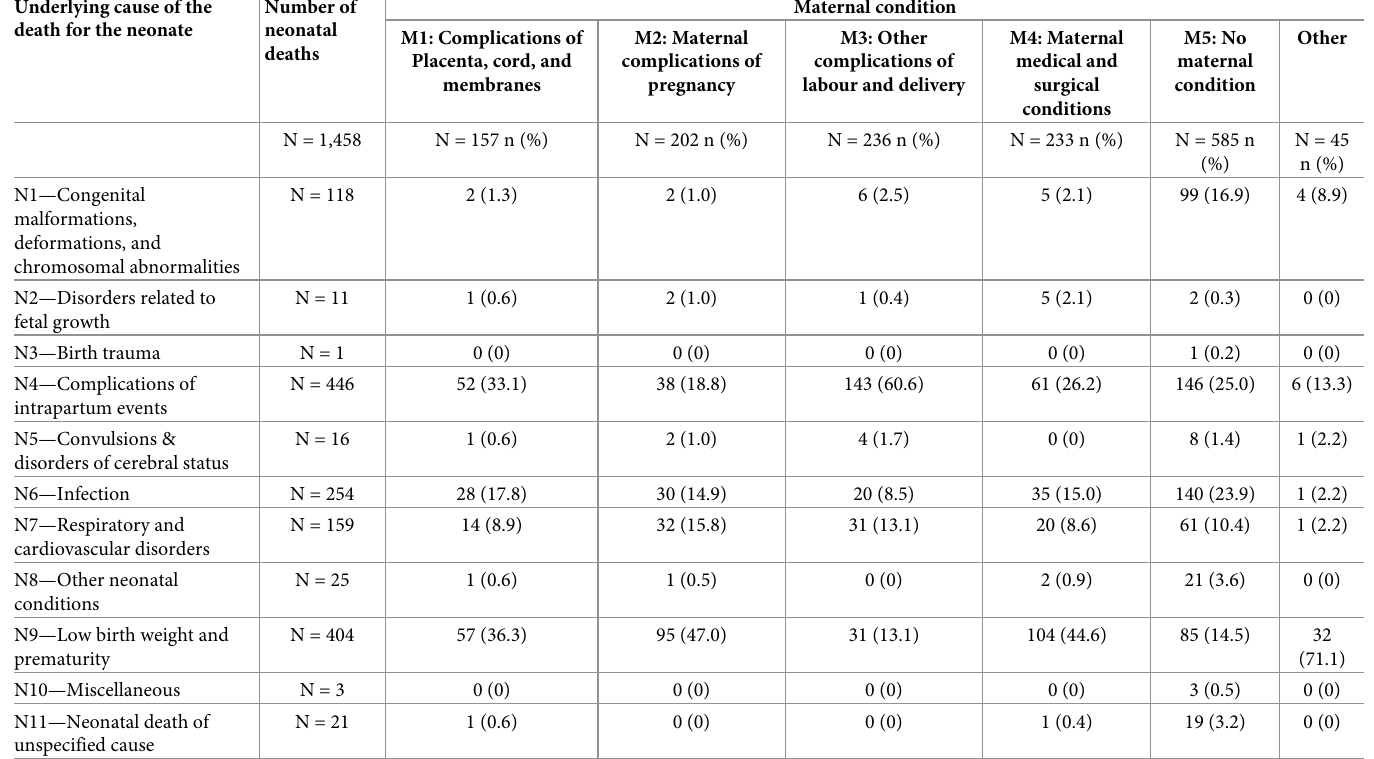
Table 3. Maternal conditions identified for CHAMPS deaths that occurred in the neonatal period, by WHO ICD 10 PM underlying cause of the death for the new- born (2016–2021). Underlying cause of the death for the neonate